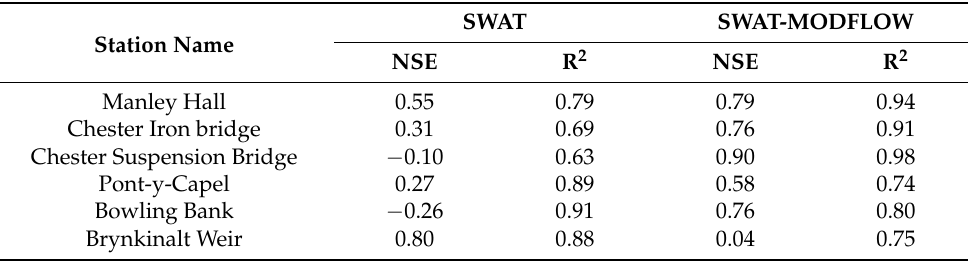
Table 5. Simulated baseflow results of the standalone SWAT model and the coupled SWAT-MODFLOW model for the calibration period of 1995–2000.